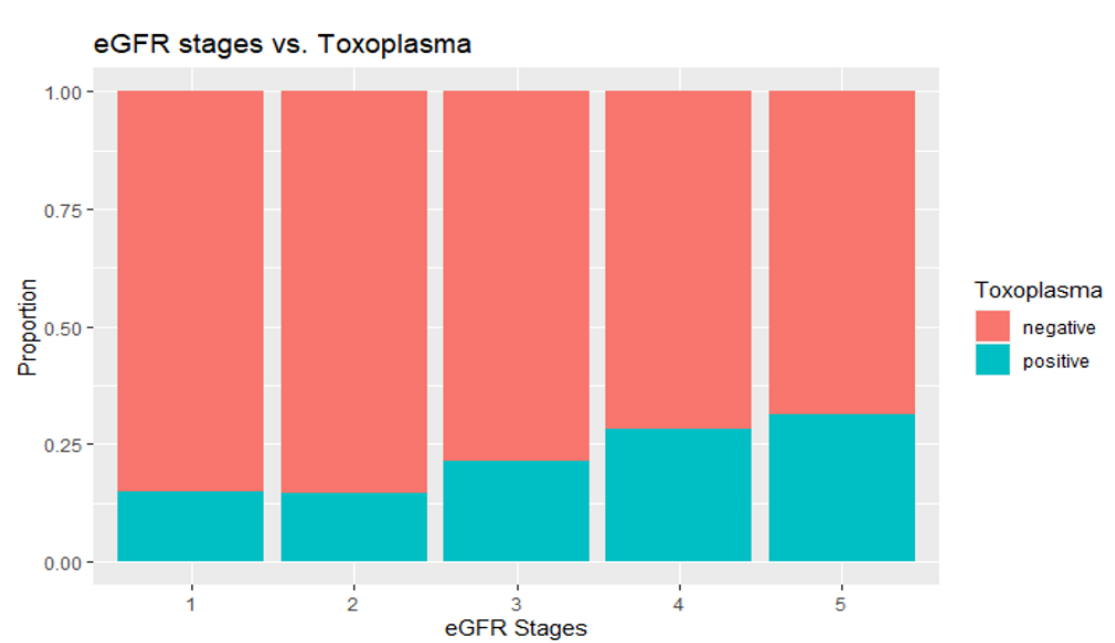
Figure 1. eGFR levels by T. gondii exposure status.